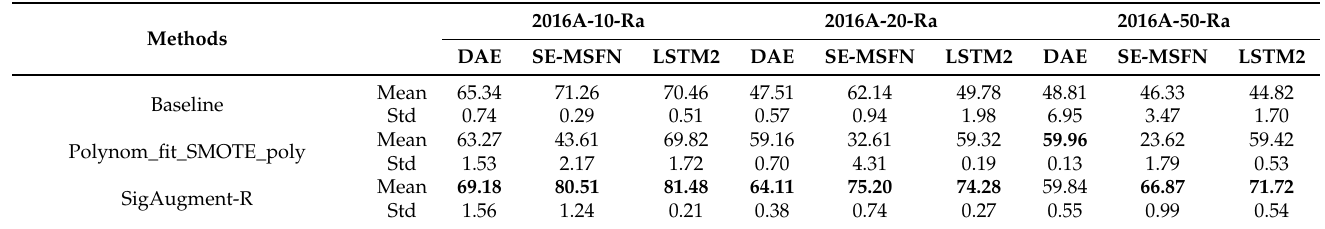
Table A5. Results of the proposed SigAugment method trained on the 2016A-10-Ra, 2016A-20-Ra, and 2016A-50-Ra datasets. The top1 mean average accuracy has been